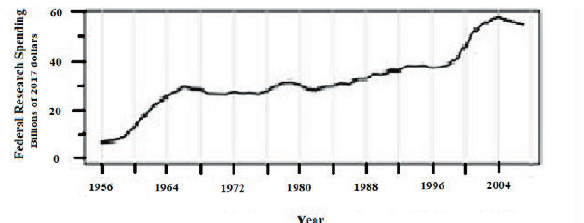
Figure 4. US Federal Government spending on research (in billions of 2017 dollars).